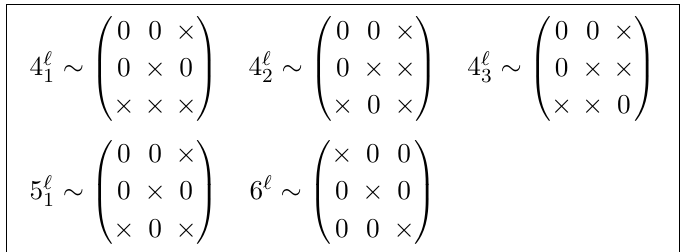
Table 3 . Textures for the charged-lepton mass matrix M ‘ .